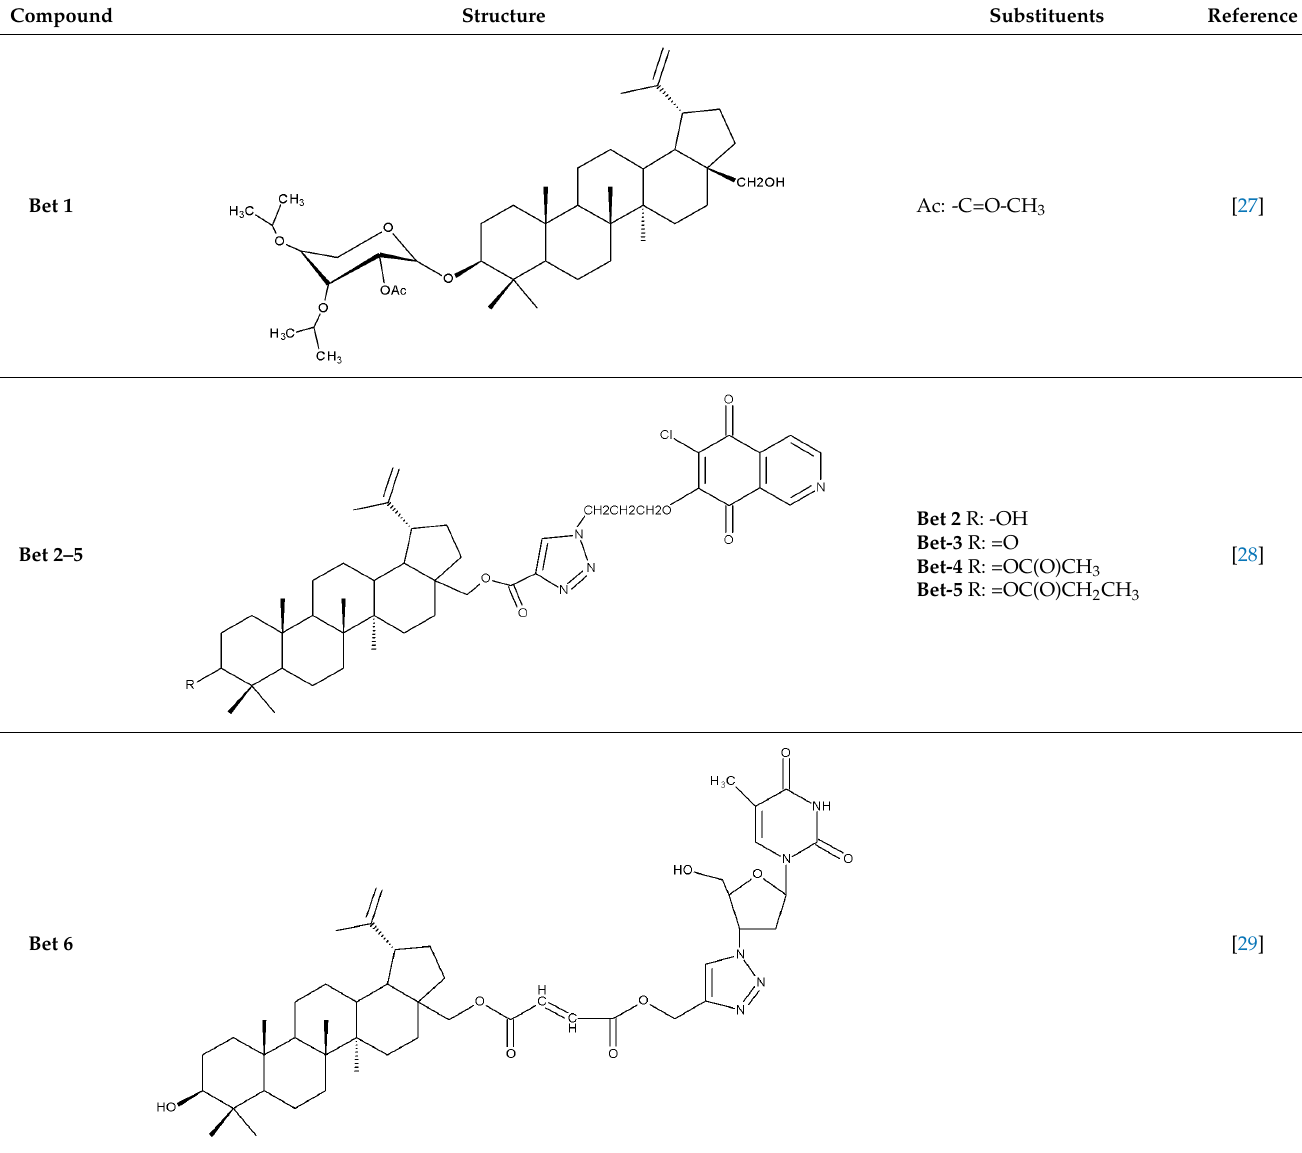
Table 2. The chemical structures of betulin derivatives.